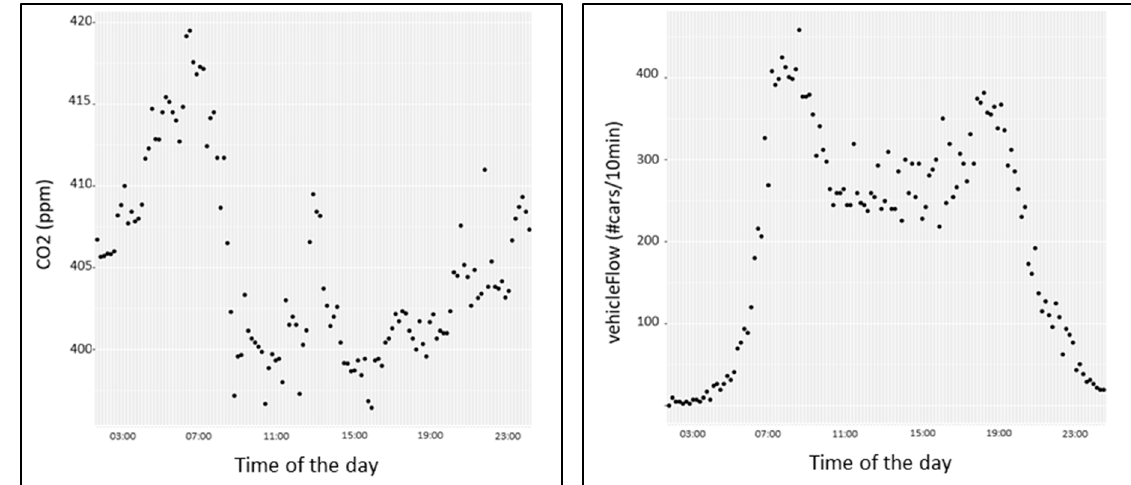
Figure 8. On the left side: the time alignment of CO 2 data in a specific location, passing from ppm/2 min to ppm/10 min, at a certain time of day. On the right side: the time alignment of traffic flow data in a specific location, passing from #cars/h to #cars/10 min, at the same time of day.